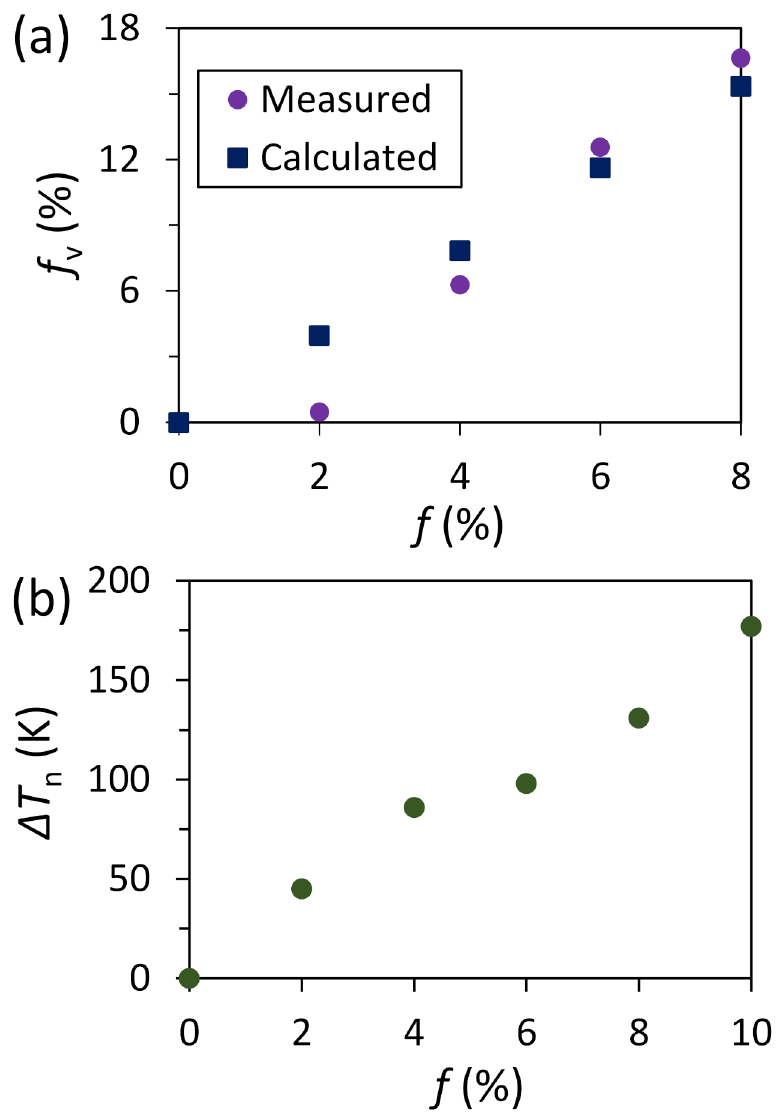
Figure 13. Effect of lattice misfit [38]. ( a ) The quantified vacancy concentration in L2 ( f v ) and ( b ) nucleation undercooling ( ∆ T n ) as a function of the initial lattice misfit ( f ). Different from the previous case with small negative misfit, after heterogeneous nucleation in systems with small positive misfit the solid has the same orientation with the substrate. This has also been confirmed by our experimental observation that there is no twist between hcp Mg and the fcc MgO substrates (Figure 14)